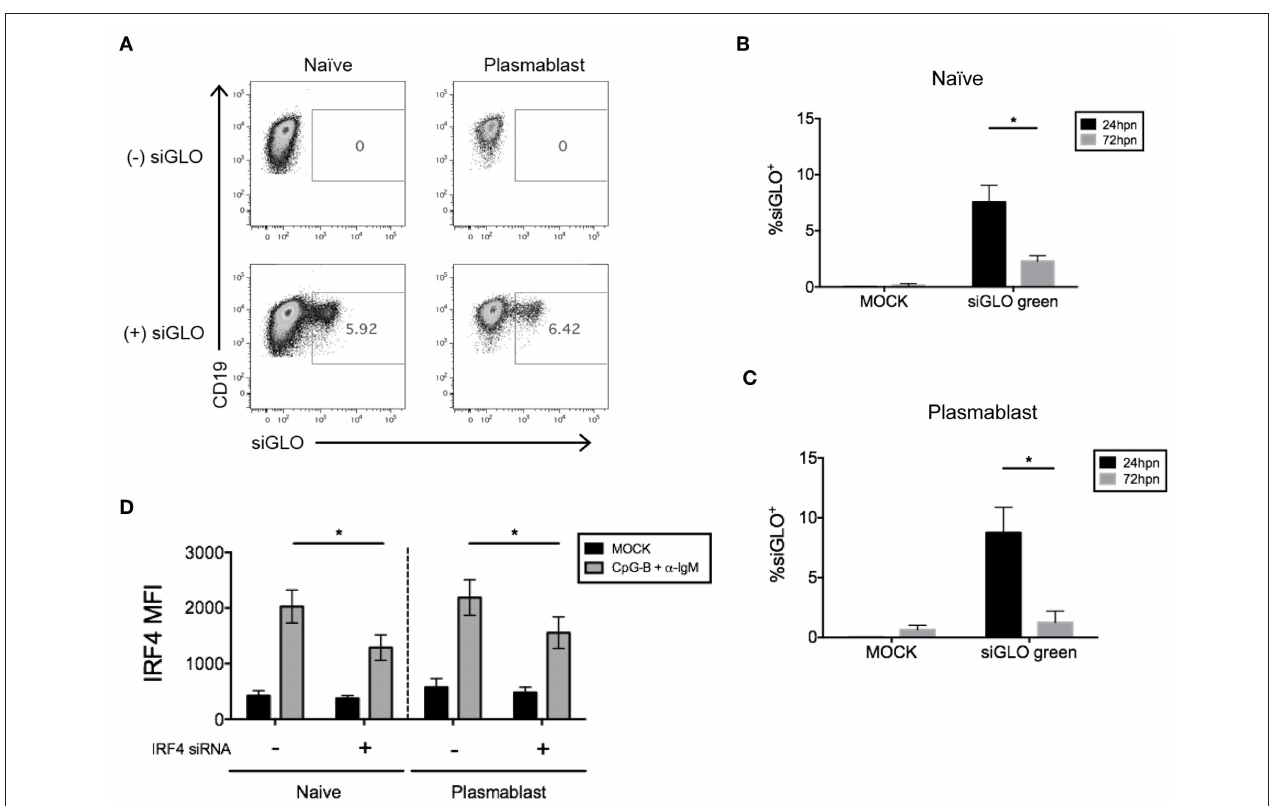
FIGURE 7 | Efficiency of siGLO co-nucleofection with IRF4 siRNA in purified total CD19 + human B cells. (A) Representative dot plots of gated naïve B cells (CD19 + IgD + ) and plasmablasts (CD19 + IgD − CD27 + CD38 + ) that are siGLO + at 24h post-nucleofection with 1.5 µ M siGLO. (B,C) Similar to (A) except data are summarized from multiple independent experiments showing siGLO nucleofection efficiency at 24 and 72h post-nucleofection in naïve B cells (B) and plasmablasts (C) ( n = 4). (D) IRF4 knockdown efficiency is retained in naïve B cells and plasmablasts after co-nucleofection of total B cells with siGLO and stimulation with anti-IgM + CpG-B for 48h ( n = 4). Bars represent mean ± SEM. P -values were determined by paired t -test for significance (* p <